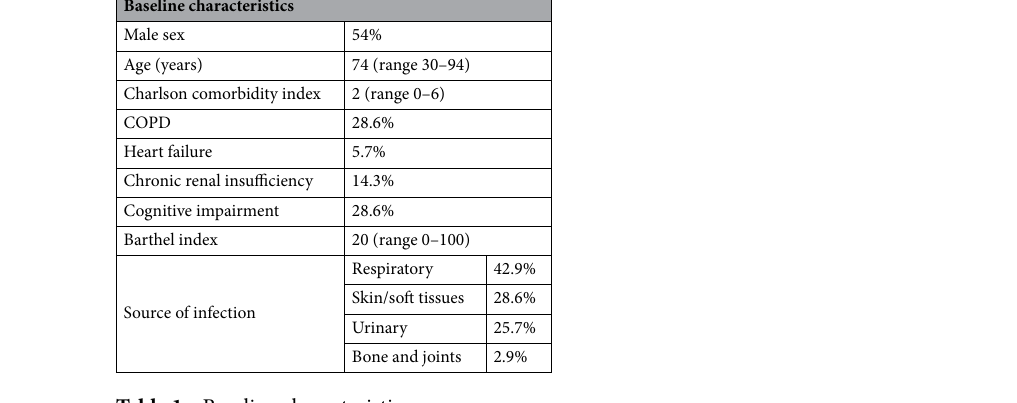
Table 1. Baseline